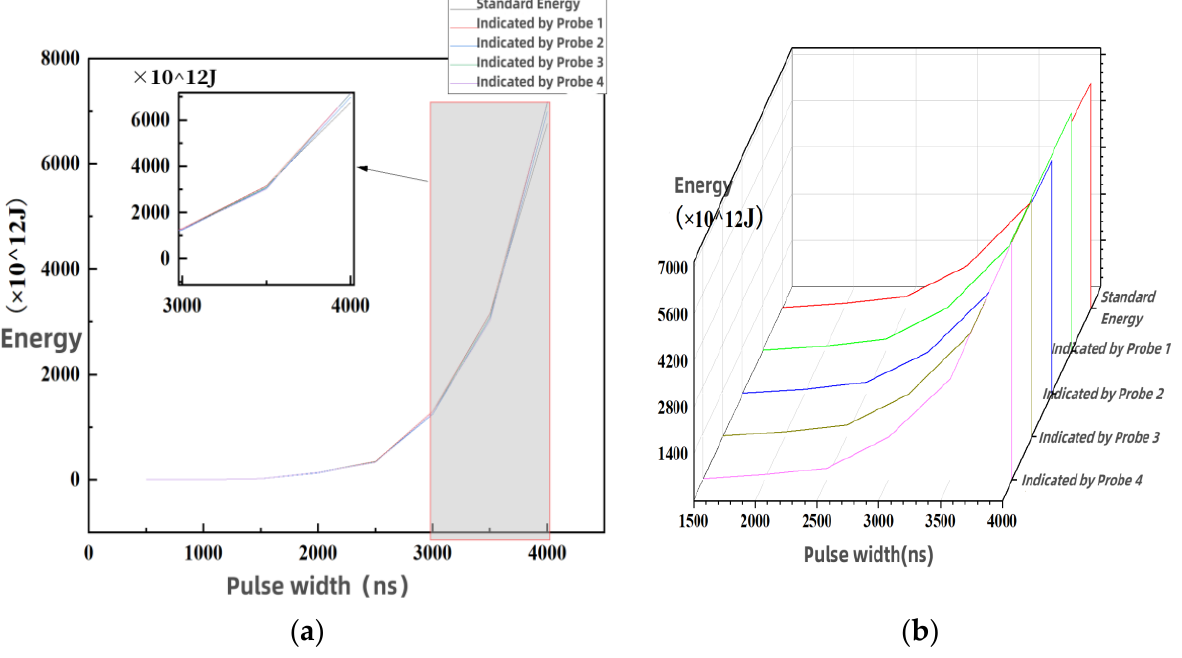
Figure 7. Energy contrast diagram of four probes, ( a ) is a plan and ( b ) is a three-dimensional dia-